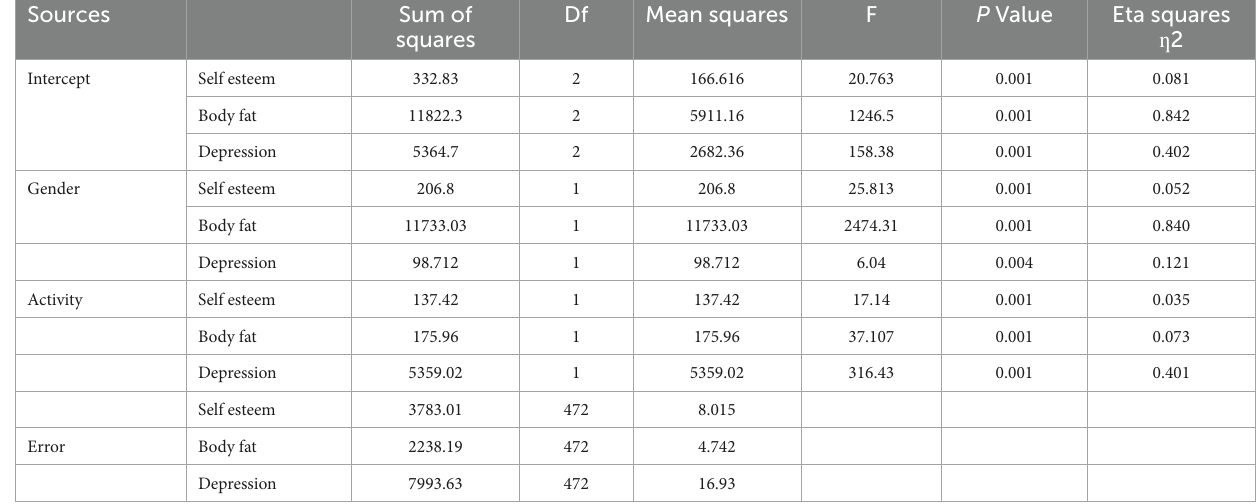
TABLE 2 Results of MANCOVA in activity and inactivity groups in three variables of self-esteem, fat percentage and depression. Sources Sum of Df Mean squares F Eta squares